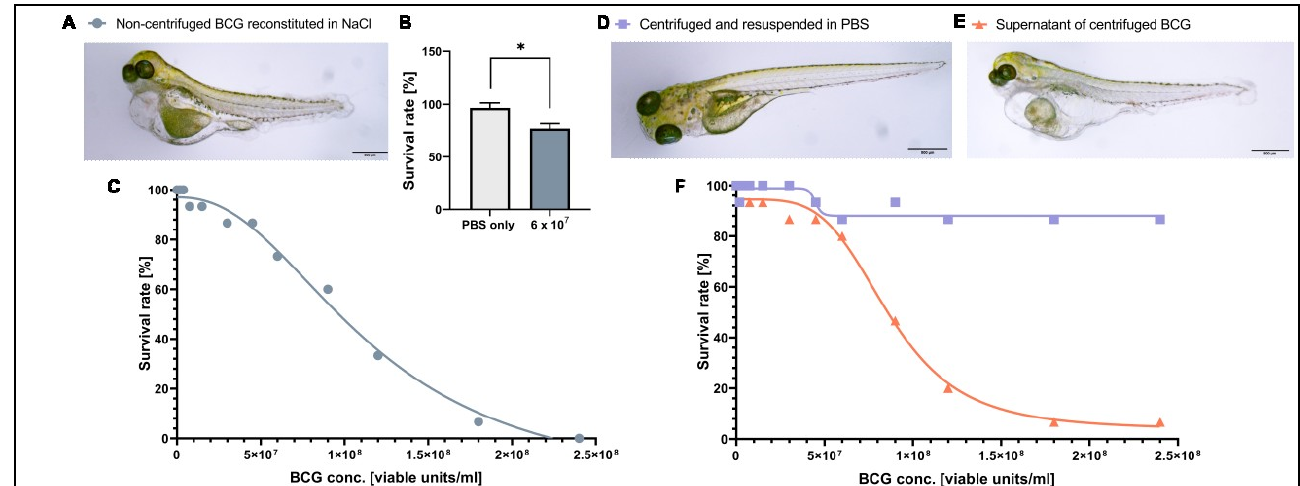
Figure 1. Toxicity of BCG-Medac is caused by a soluble component of the powder. ( A ) Light micrograph image of 5-day-old zebrafish larvae three days after having received a subcutaneous injection of ~3 nL of completely reconstituted BCG-Medac. ( B ) Quantification of larval survival at 5 days post-fertilization, three days after subcutaneous injection of ~3 nL of completely reconstituted BCG-Medac, or only PBS (vehicle). ( C ) Graph showing the proportion of larvae that survived at 5 days post-fertilization, three days after injection with the indicated concentrations of 3 nL of completely reconstituted BCG-Medac. ( D , E ) Light micrograph images of 5-day-old zebrafish larvae three days after having received a subcutaneous injection of ~3 nL of pelleted and re-suspended bacteria ( D ) or supernatant ( E ) from the reconstituted BCG-Medac powder. ( F ) Graph showing the proportion of larvae that survived at 5 days post-fertilization, three days after injection with ~3 nL of pelleted, and re-suspended bacteria (blue line) or supernatant (orange line) from the reconstituted BCG-Medac powder. n = 15 embryos per group. *: p < 0.05.